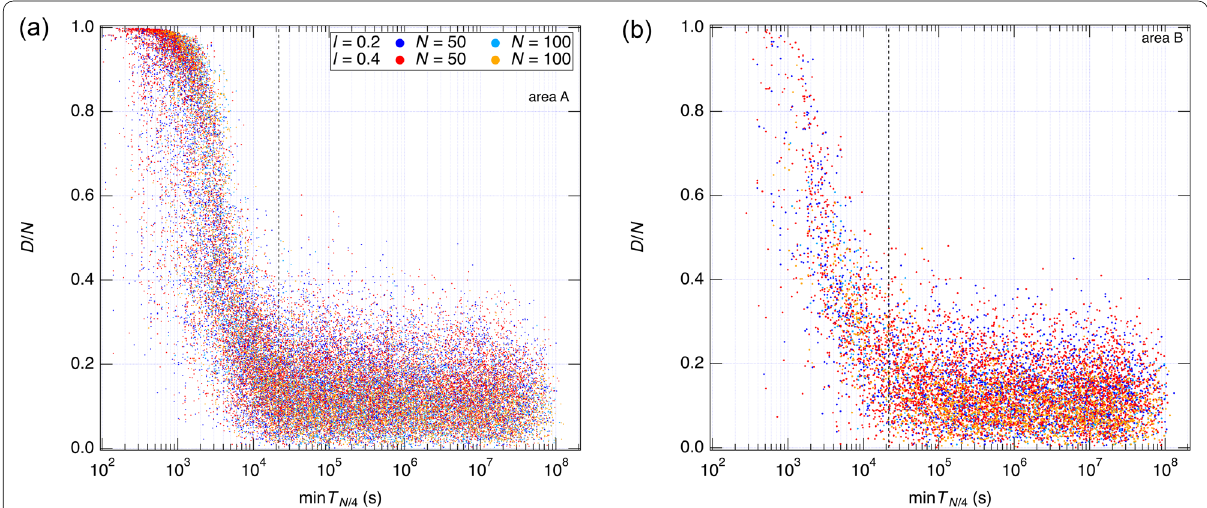
Fig. 2 Relationship between the D -value normalized by N and min T N / 4 . a Estimation results for area A; b estimation results for area B. The vertical dashed line indicates 21,600 s (6 h)